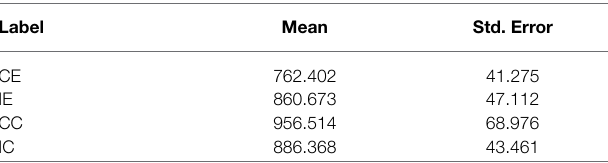
TABLE 1 | Mean of the participants’ reaction times for each example of wine labeling, and standard error of the mean. Label Mean Std.